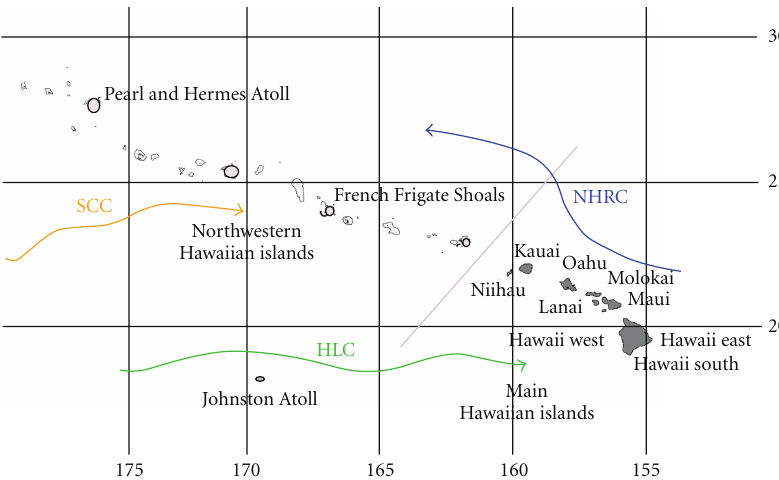
Figure 1: Scaled map of island and atoll collections of Acanthaster planci along the Hawaiian Archipelago and Johnston Atoll. High islands are represented in dark gray. Submerged reef area to a 30 meter isobath is outlined in light gray. The blue line represents the North Hawaiian Ridge Current (NHRC), the green line represents the eastward Hawaiian Lee Countercurrent (HLC), and the orange line presents the Subtropical Countercurrent